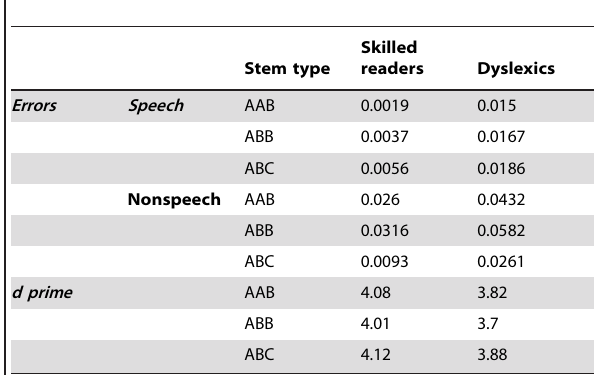
Table 3 . Accuracy (proportion errors) of skilled and dyslexic participants in speech/nonspeech discrimination (Experiment